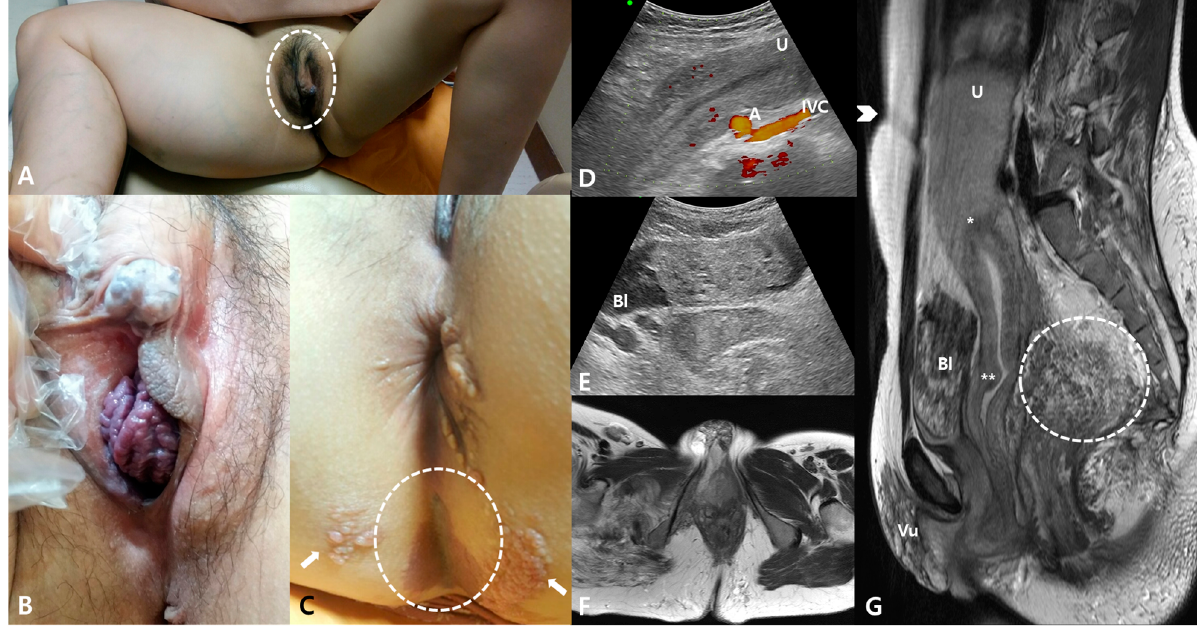
Figure 1. ( A ) Hemihypertrophy of the right lower limb, hemangioma of the right vulva, and ambiguous genitalia with an elongated clitoral hood, approximately 4 cm in length (shown in the dotted circle). ( B ) An enlarged, 2.0 × 1.8-cm 2 whitish globular clitoris glans and a purplish bulging anterior vaginal wall. ( C ) Typical port-wine nevus (dotted circle) and bullous plaques (arrows) on the buttock. ( D ) The upper margin of the uterine fundus (U) was noted around the abdominal aorta ( A ) and inferior vena cava (IVC) on sonography. ( E ) A typical sponge-like shadow consisting of a mass-like lesion without Doppler flow in the bladder (Bl) was observed by sonography. ( F ) Hemihypertrophy of the right lower limb and hemangioma of the right vulva with an enlarged clitoris viewed with MRI. ( G ) A typical sponge-like shadow in the bladder (Bl) and rectum (dotted circle) viewed in T1-weighted images, and an extensive cavernous hemangioma in the pelvis pushing the uterine fundus (U) up to above the umbilicus (arrowhead) shown on MRI. * (internal cervical os); ** (external cervical os).